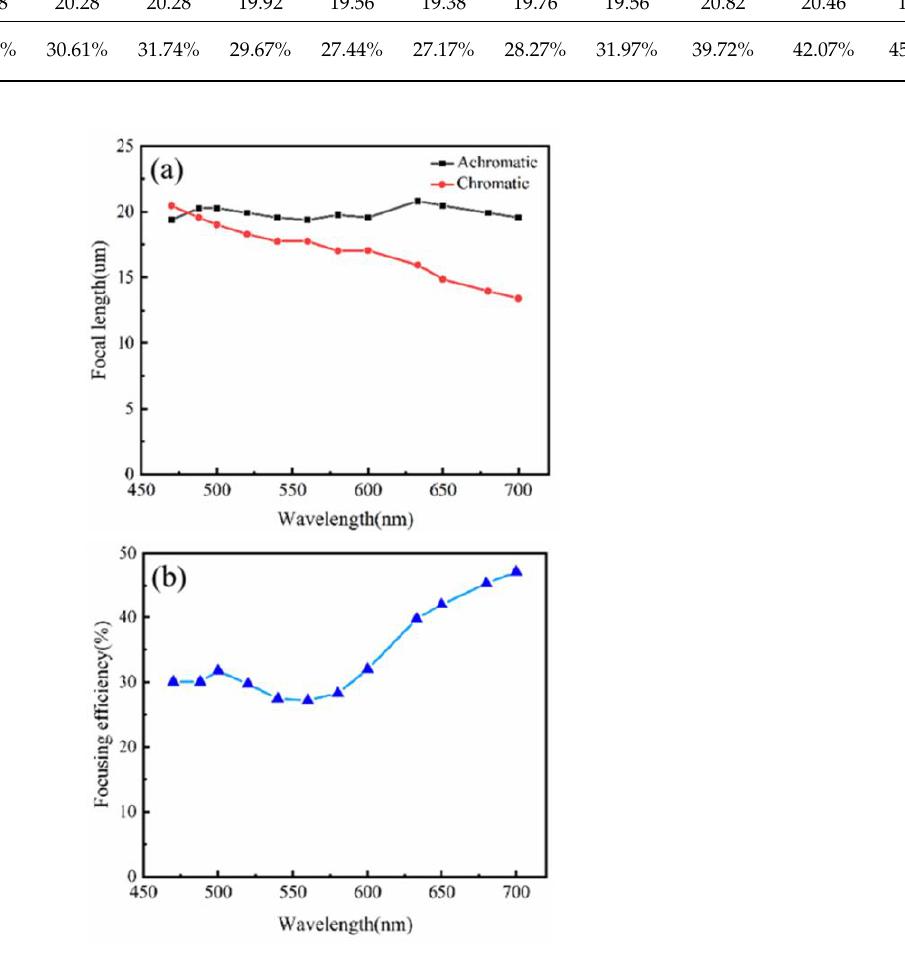
Figure 7. ( a ) Focal length for the chromatic and achromatic metalens of 470–700 nm; ( b ) focusing efficiency for the achromatic metalens of 470–700 nm. Table 3. Summary of features of achromatic metalenses in the visible light spectrum .